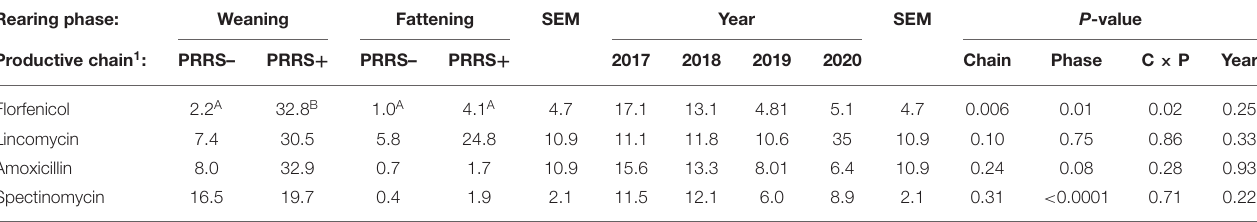
TABLE 3 | Consumption of two main class C antibiotics, florfenicol and lincomycin, and two main class D antibiotics, amoxicillin and spectinomycin, in the pig production chain differentiated by the occurrence of porcine reproductive and respiratory syndrome (expressed as mg of active compound per total kg of meat produced). Rearing phase: Weaning Fattening SEM Year SEM P -value Productive chain 1 : PRRS– PRRS